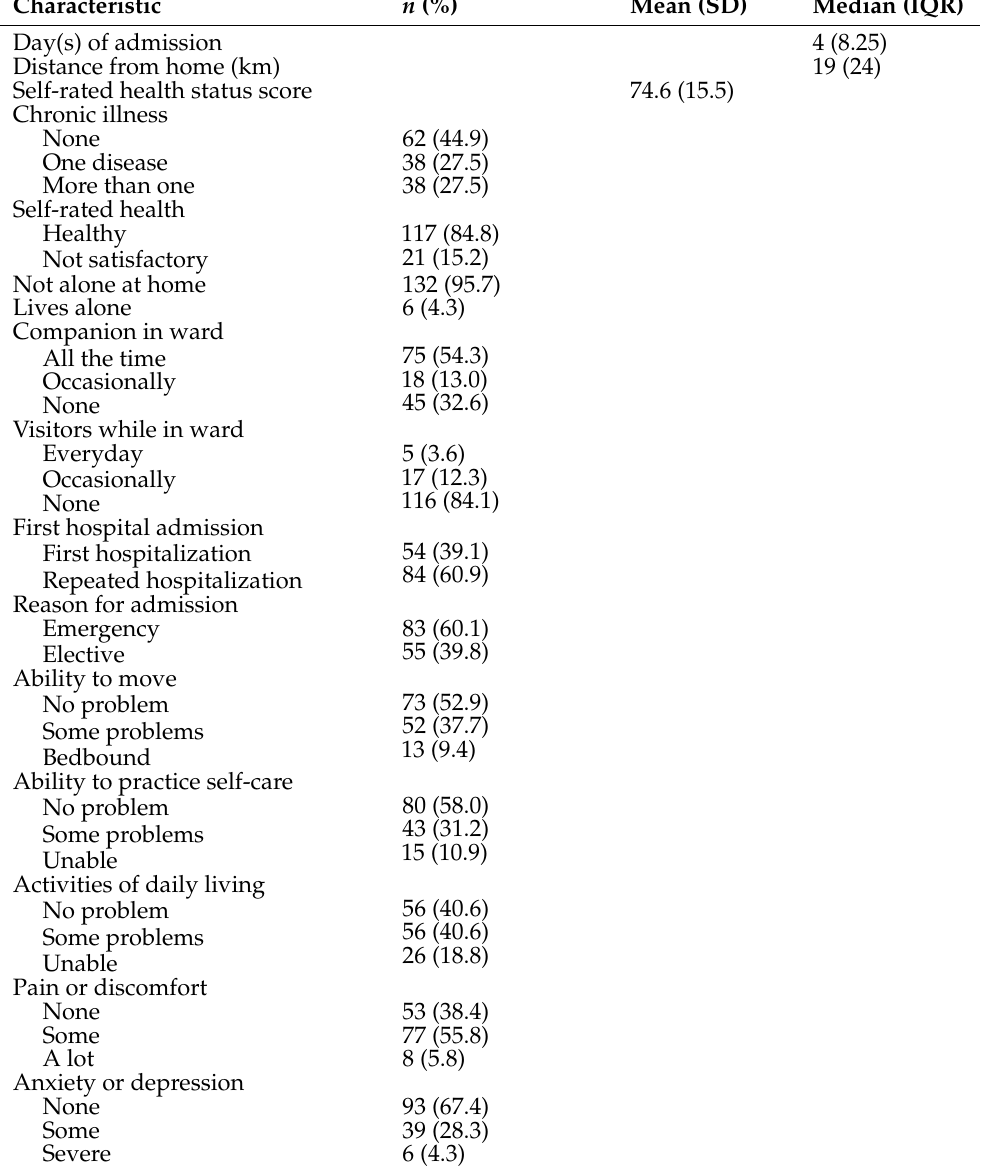
Table 2. Medical and admission background ( n =